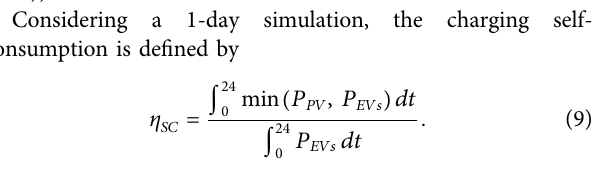
Δ (cid:9) P PCC (red trace)